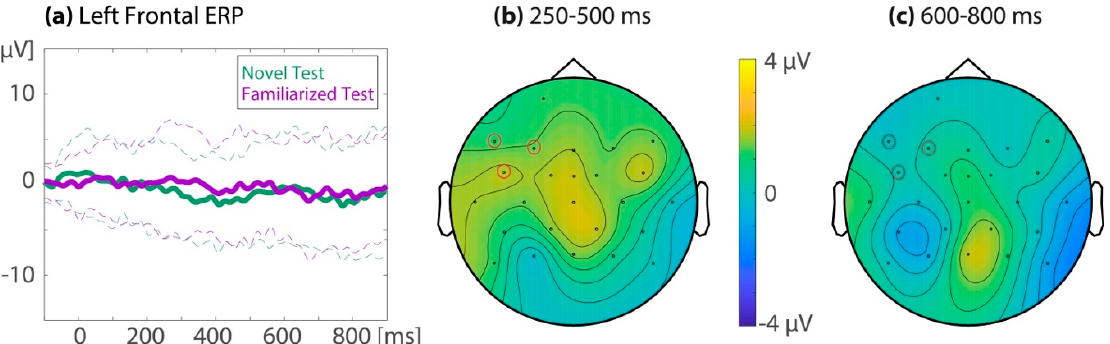
Figure 5. Familiarity effect in the test phase for the combined sessions (32 subjects). ( a ) Event-related potentials (ERP) averaged over left-frontal electrodes (red circles in ( b ) and ( c )). The solid lines are the ERPs from the novel control words in the test phase (in green) and the familiarized target words in the test phase (in purple). The means ±1 SD are given as dotted lines. Right: Topographic isovoltage maps of the difference between the familiarized target words and novel control words during test, in the ( b ) 250–500 ms and ( c ) 600–800 ms latency ranges. The red circles indicate electrodes that are part of the left-frontal region of interest.